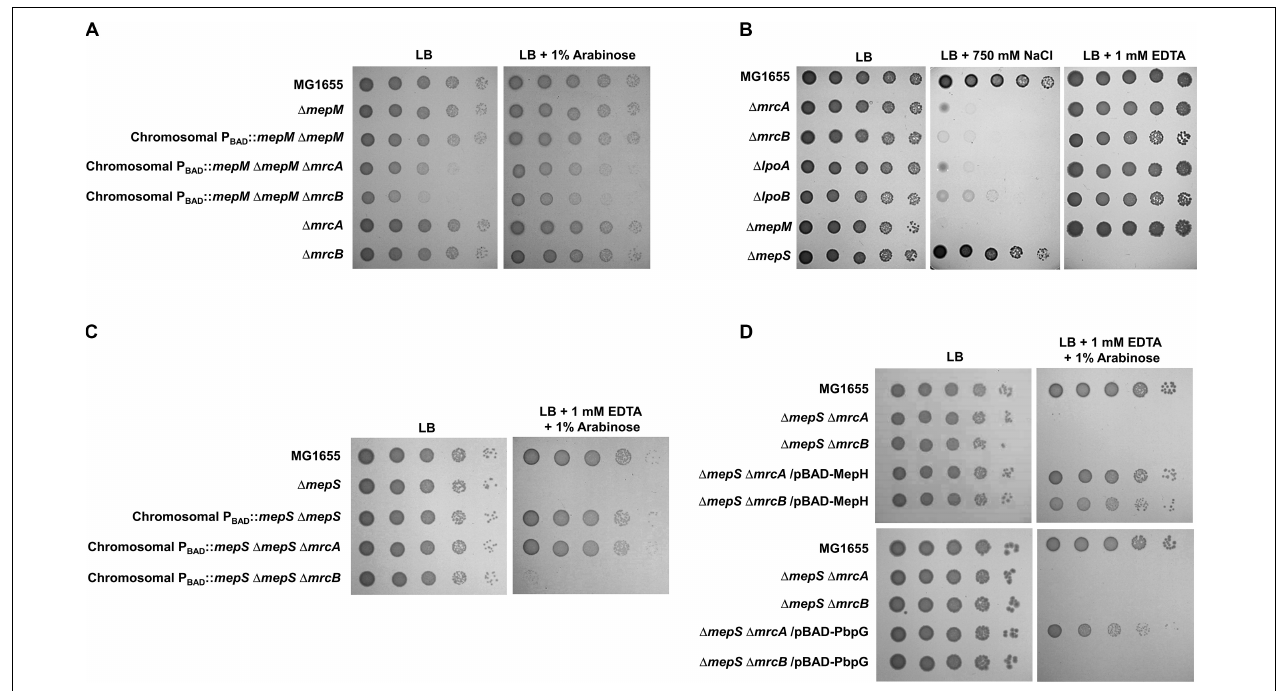
FIGURE 5 | Distinct effects of MepM, MepS, MepH, and PbpG on PBP1a and PBP1b. (A) The effect of MepM on PBP1a and PBP1b. The cells of the indicated strains were serially diluted from 10 8 to 10 4 cells/mL in 10-fold steps and spotted onto an LB plate or an LB plate containing 1% arabinose. (B) Salt sensitivity of the mrcA , mrcB , lpoA , and lpoB mutants. The cells of the indicated strains were serially diluted from 10 8 to 10 4 cells/mL in 10-fold steps and spotted onto an LB plate or LB plates containing 750 mM NaCl or 1 mM EDTA as indicated. (C) The effect of MepS on PBP1b. The cells of the indicated strains were serially diluted from 10 8 to 10 4 cells/mL in 10-fold steps and spotted onto an LB plate or an LB plate containing 1 mM EDTA and 1% arabinose. (D) The effects of MepH and PbpG on PBP1a and PBP1b. The cells of the indicated strains were serially diluted from 10 8 to 10 4 cells/mL in 10-fold steps and spotted onto an LB plate or an LB plate containing 1 mM EDTA and 1%